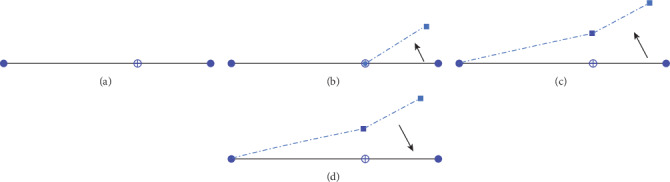
Tail swing diagram.